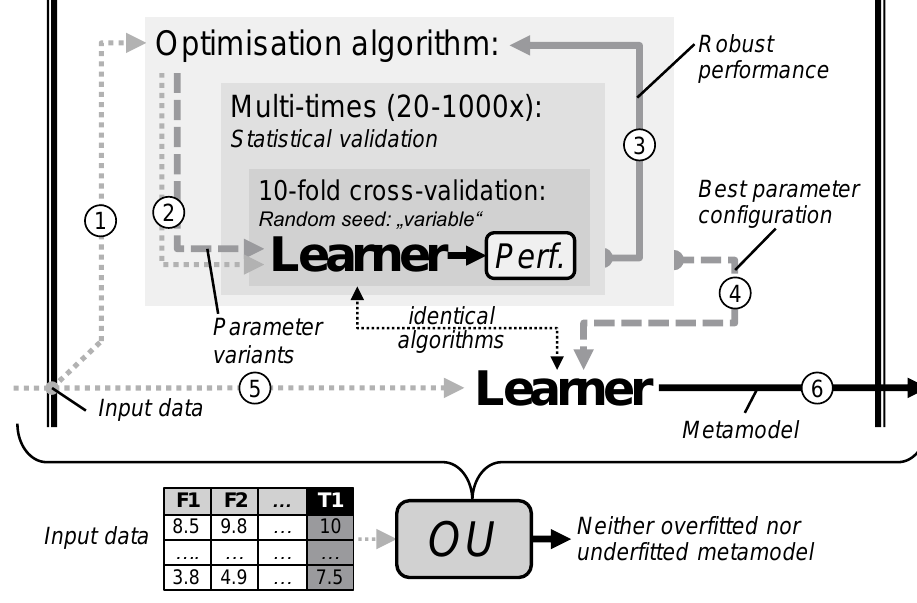
Figure 7. The optimisation unit (OU).